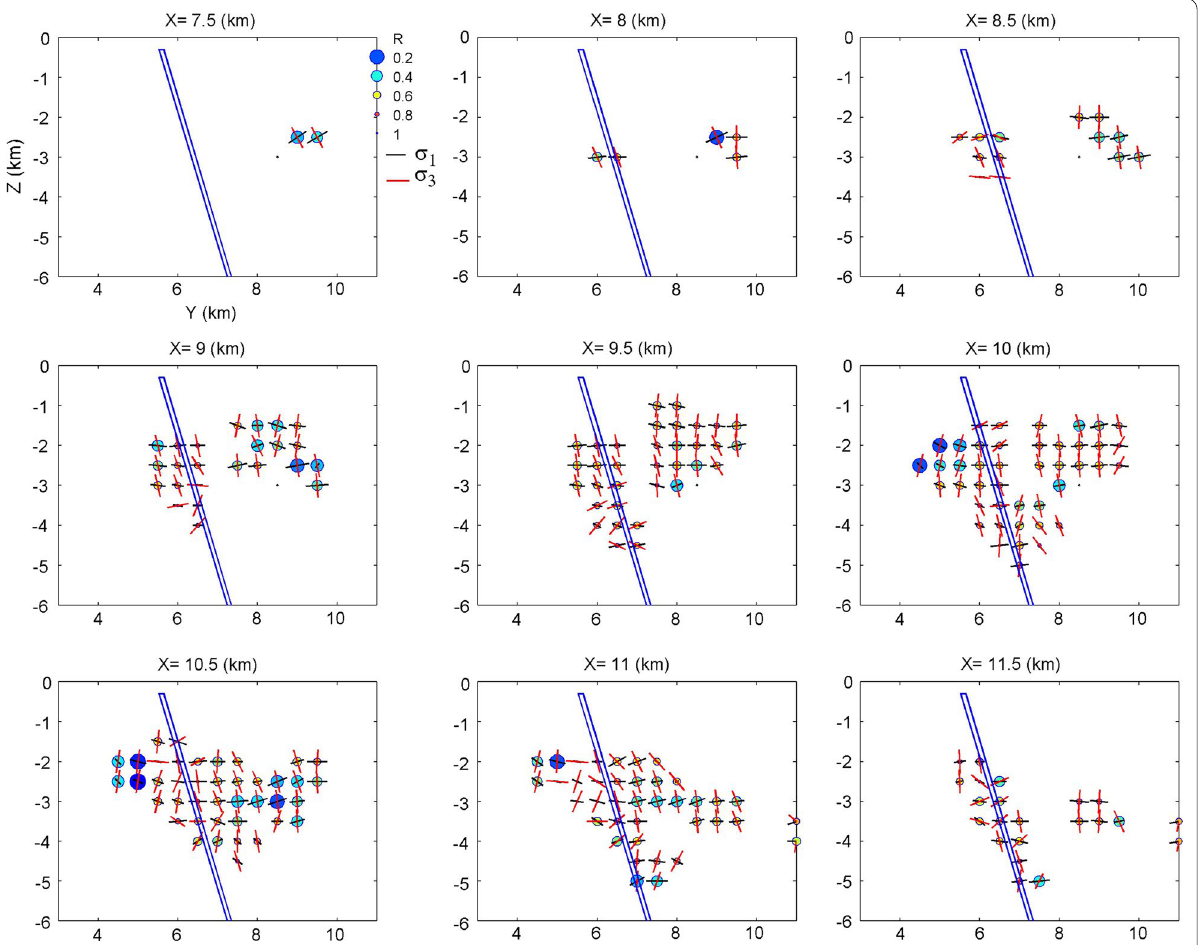
Fig. 6 Results of stress inversion projected onto vertical planes perpendicular to the fault strike of the mainshock. Other explanations are the same as for Fig.